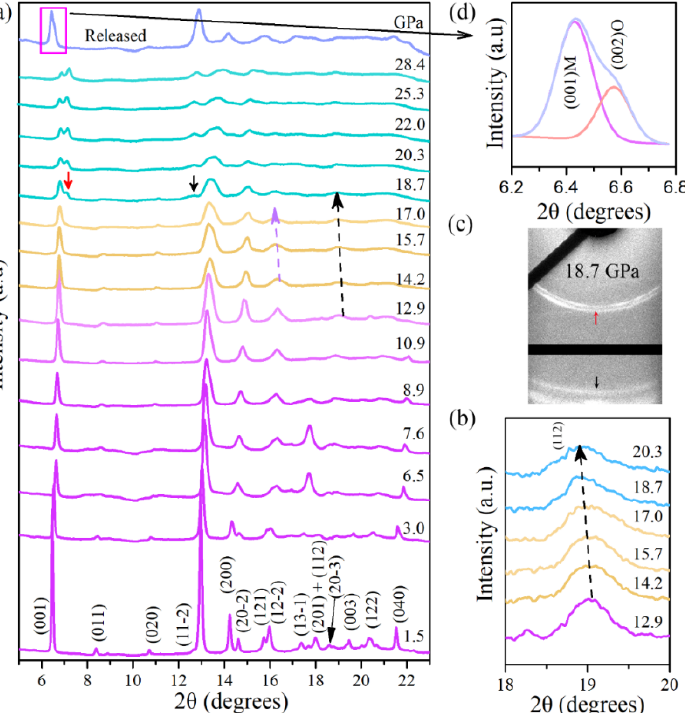
Figure 2. ( a ) The representative ADXRD patterns of Cu(OH)Cl measured at pressures up to 28.4 GPa at room temperature and released to ambient pressure (top pattern). The down arrows are used to mark the emergence of new peaks. ( b ) An enlarged view of the Bragg peak (1 1 2). ( c ) The two-dimensional ADXRD pattern of Cu(OH)Cl at 18.7 GPa. ( d ) The enlarged view of the split-peak fit near 6.2 Å after decompression.